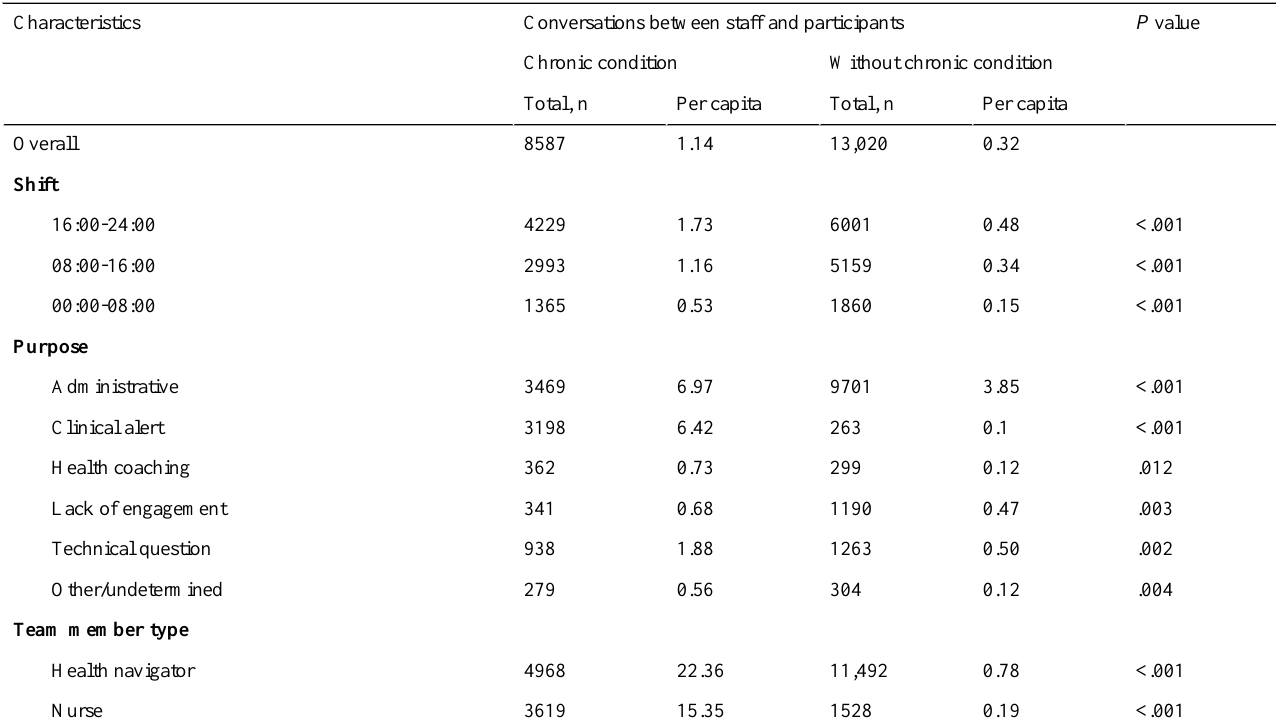
Table 2. Number of total conversations and conversations per patient between staff and participants with and without chronic conditions by shift, purpose, and staff role.